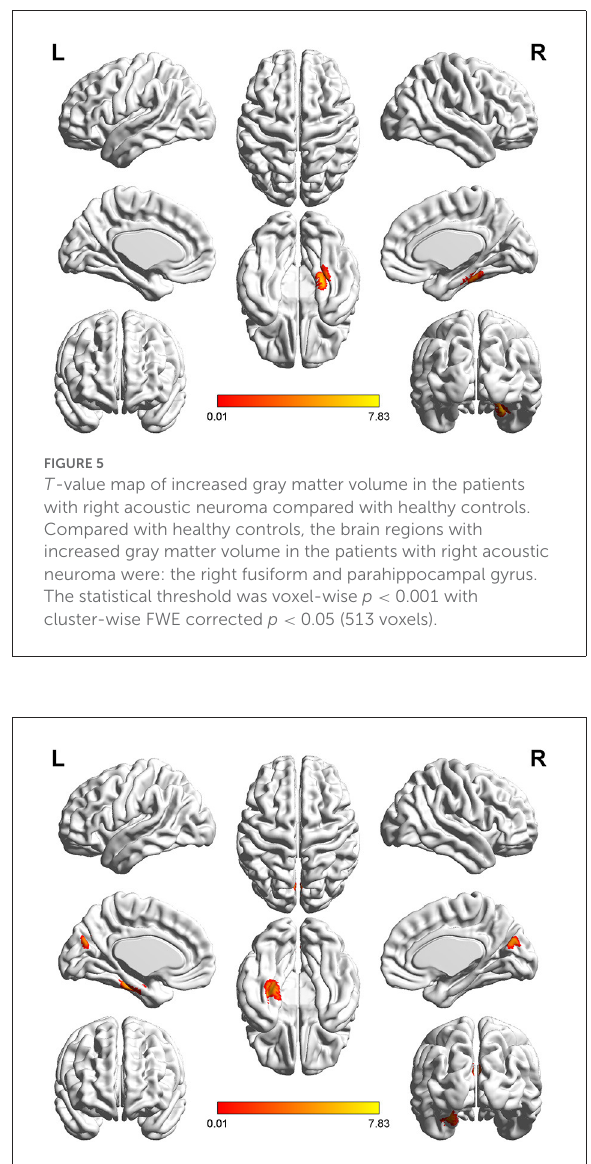
FIGURE6 T -value map of increased gray matter volume in the patients with left acoustic neuroma compared with right acoustic neuroma. Compared with the patients with right acoustic neuroma, the brain regions with increased gray matter volume in the patients with left acoustic neuroma were: the left parahippocampal gyrus and fusiform. The statistical threshold was voxel-wise p < 0.001 with cluster-wise FWE corrected p < 0.05 (319